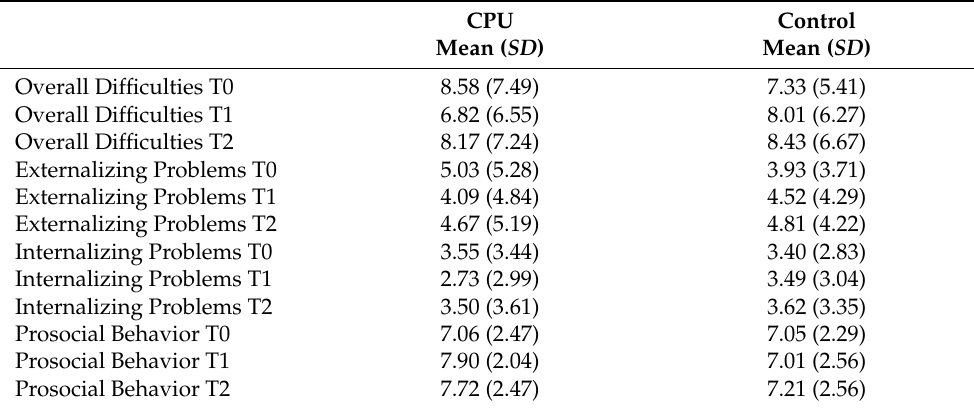
Table 1. Descriptive statistics for the SDQ